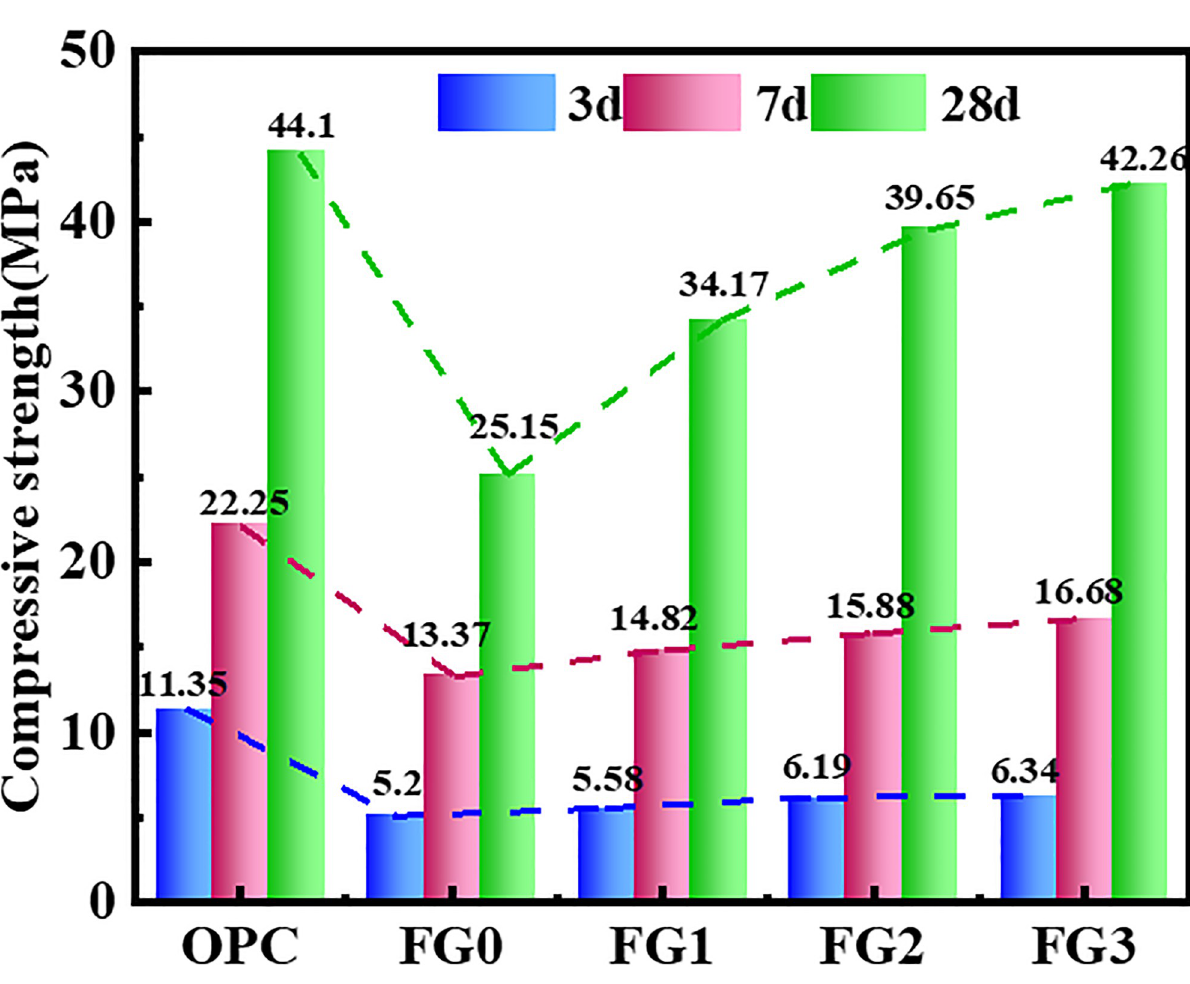
Fig 5. Compressive strength of cement slurry and